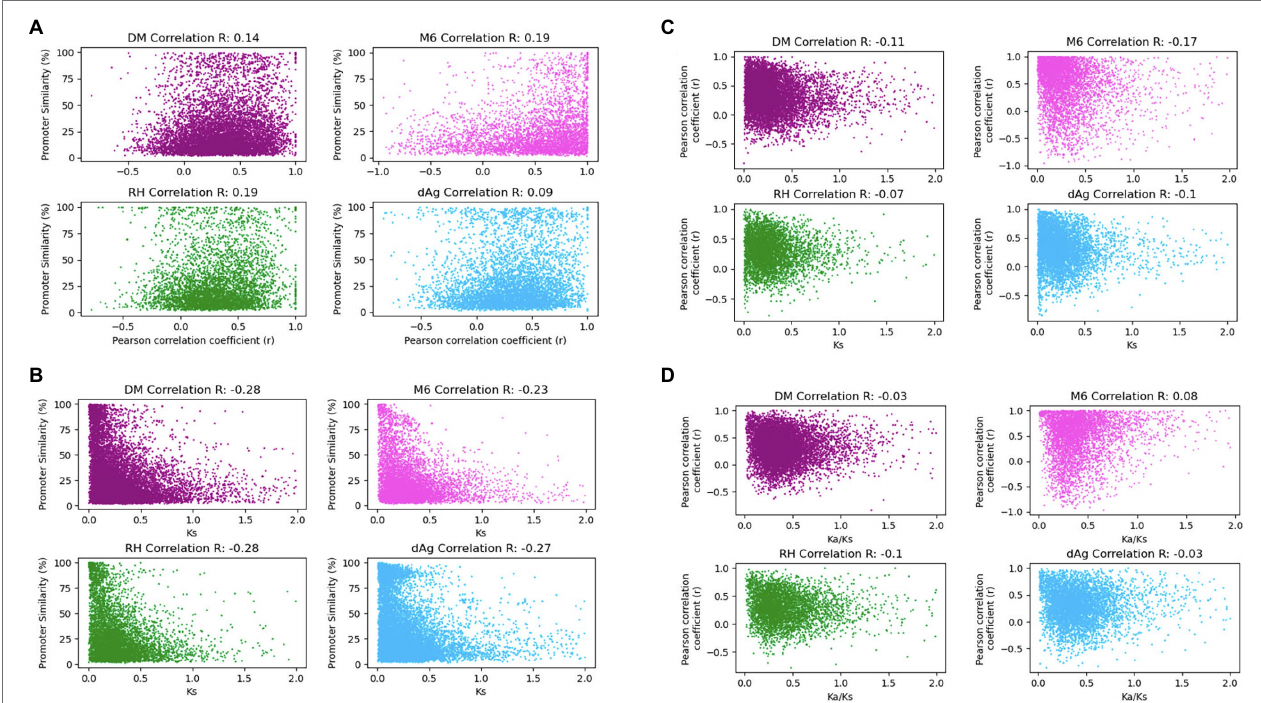
FIGURE 8 | (A) Promoter associated with gene expression correlation ( r ). Gene expression correlation (Pearson r ) on x -axis was plotted against promoter similarity within TDGs in DM, M6, RH, and dAg. (B) Promoter similarity coupled to protein divergence correlations. Protein divergence time K s on x -axis plotted against promoter similarity within TDGs in DM, M6, RH, and dAg. (C) Protein divergence time K s uncoupled to gene expression (Pearson r ). Gene expression correlation (Pearson r ) on y -axis was plotted against protein divergence time K s within TDGs in DM, M6, RH, and dAg. (D) K a / K s uncoupled to gene expression (Pearson r ). Gene expression correlation (Pearson r ) on y -axis was plotted against K a / K s within TDGs in DM, M6, RH, and